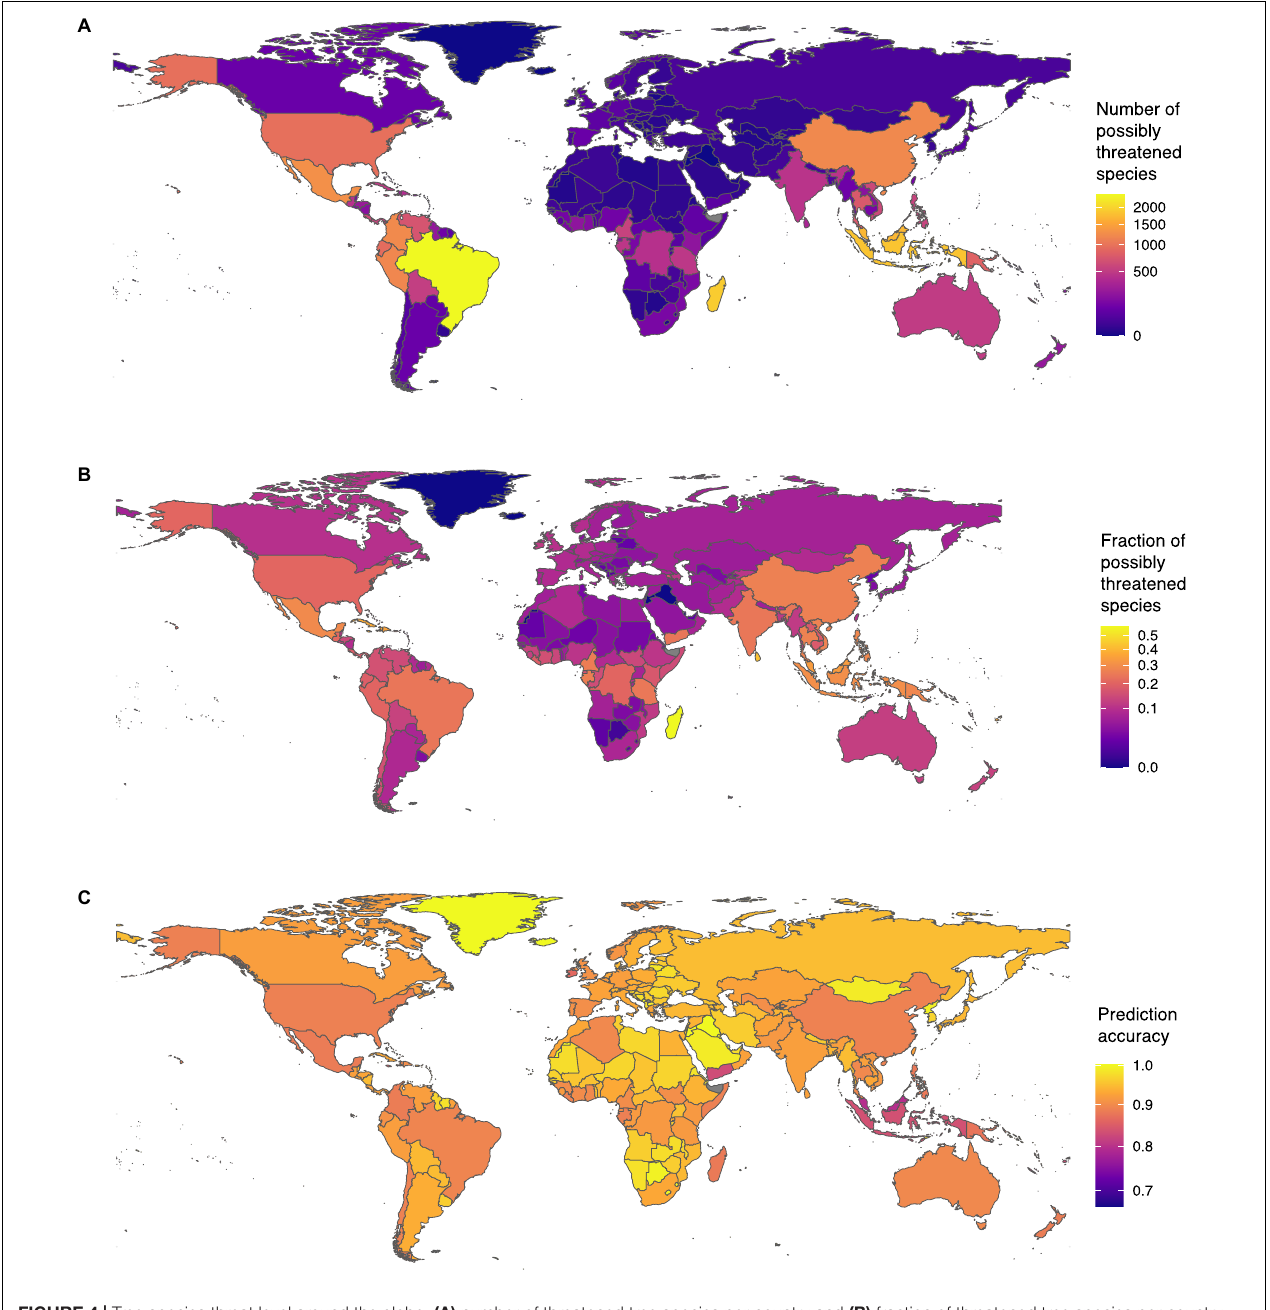
FIGURE 4 | Tree species threat level around the globe: (A) number of threatened tree species per country and (B) fraction of threatened tree species per country (with at least 5 assessed species). (C) Prediction accuracy across countries: Despite the spatial biases in IUCN RL assessments, our model performed well with estimated accuracy above 80% in most